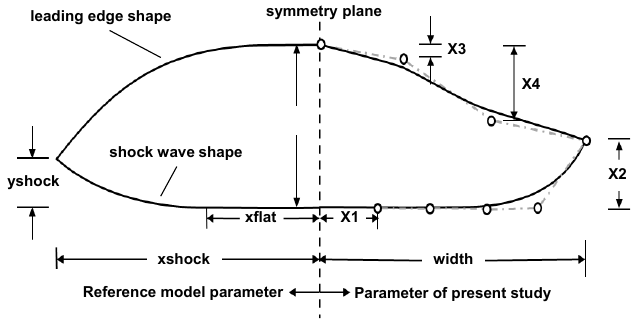
Figure 3. Waverider design curves and design parameters at the base plane.